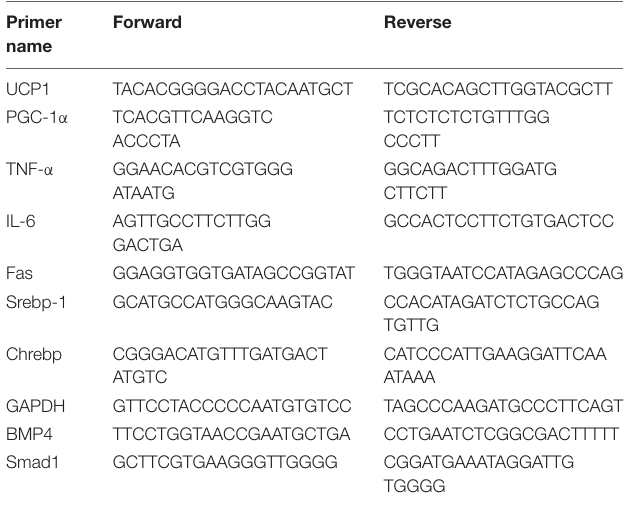
TABLE 2 | Primers used for quantitative real-time